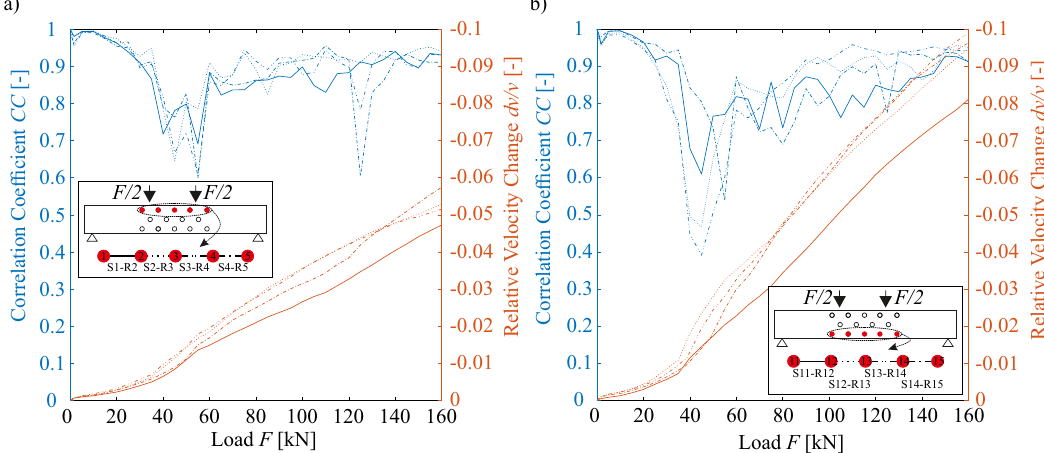
Figure 8. Stepwise Correlation Coefficient CC and cumulative Relative Velocity Change dv / v for selected transducer pairs in the ( a ) compressive and ( b ) tensile